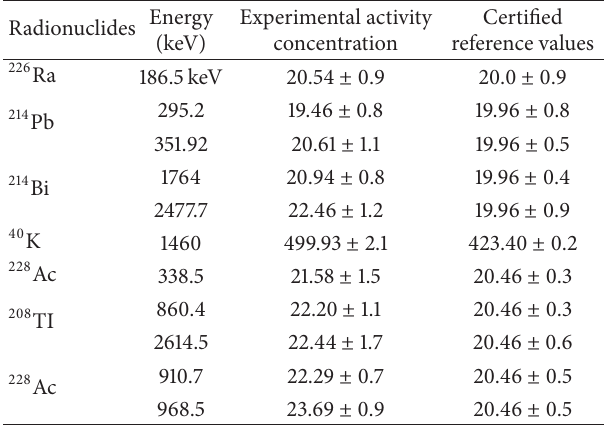
Table 1: The Standard reference values and experimental activity values of the IAEA reference soil 375 (Bq/kg ± SD).